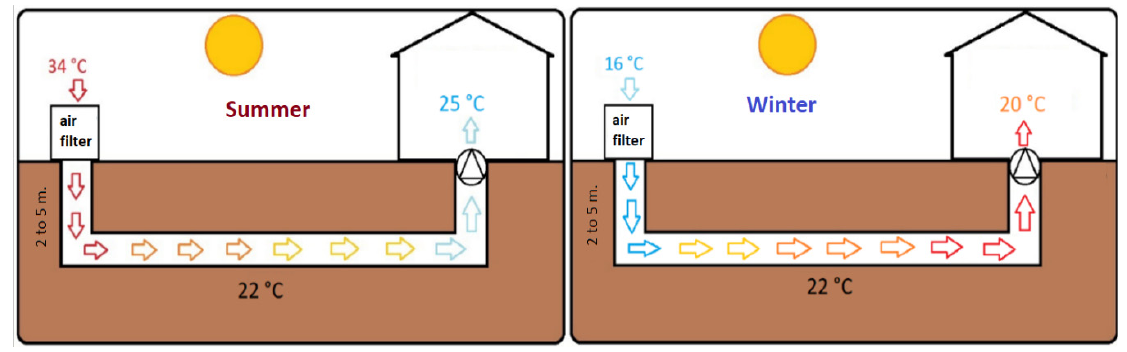
Figure 1. Basic principle of operation of a ground-to-air heat exchanger (GAHE).